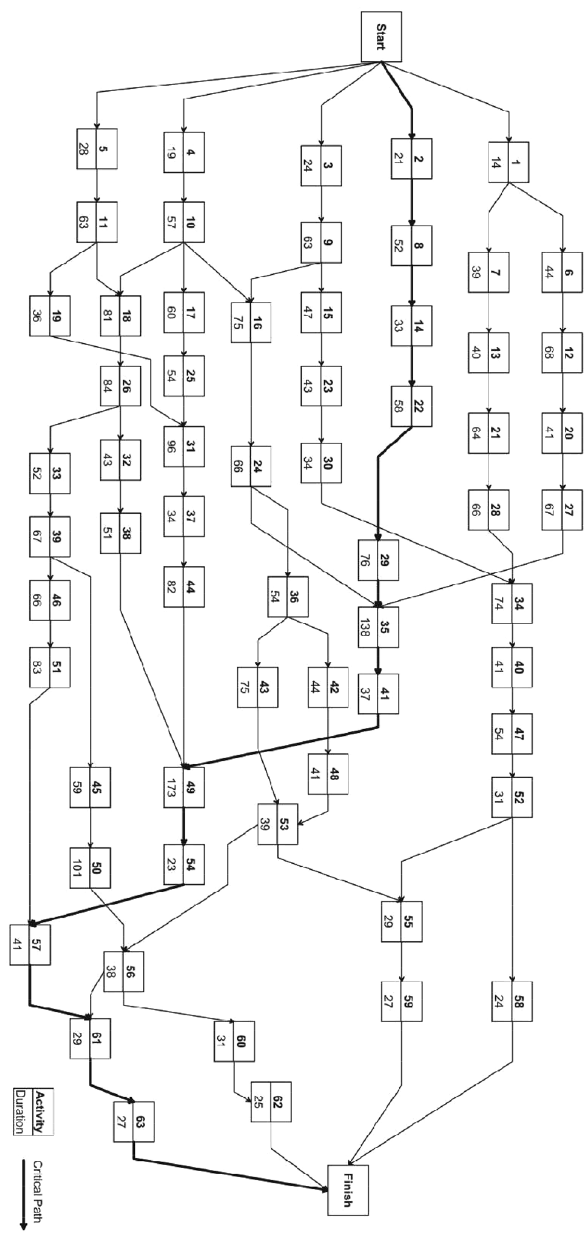
Figure 10. Activity on the node (AoN) representation of the 63-activity network (Aminbakhsh and Sonmez 20